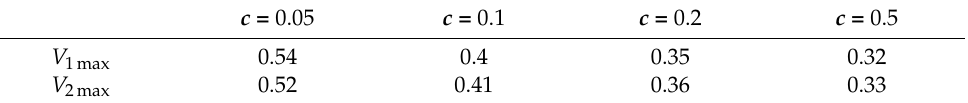
Table 2. The maximum applied voltages V 1 and V 2 for various amounts of c and considering p = 19, q = 17, and β = 50.